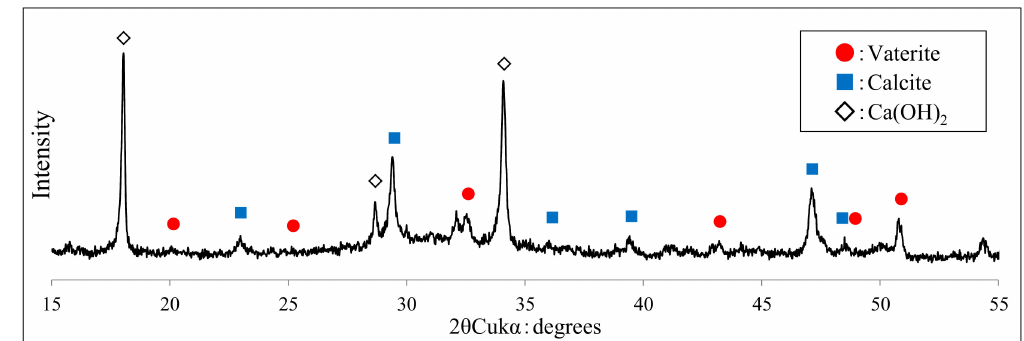
Figure 13. XRD patterns at 20 ◦ C (CE specimen of IV series).